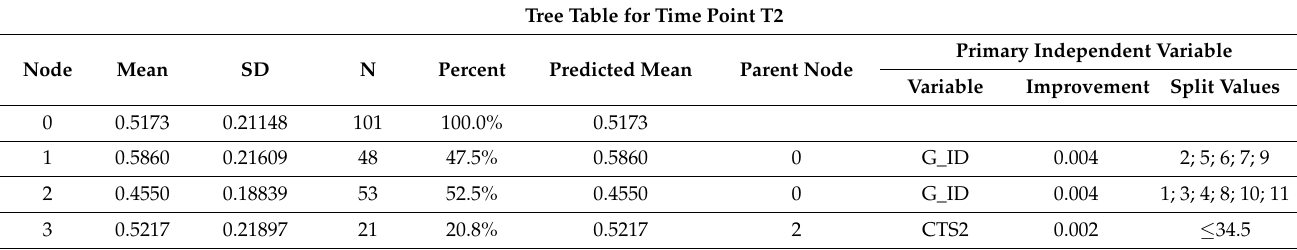
Table A4. Results description in table format for the designed C&RT Model 2. Tree Table for Time Point